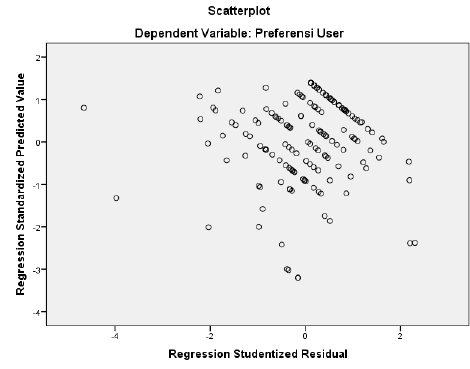
Fig. 7 Scatterplot of heteroscedasticity test from user